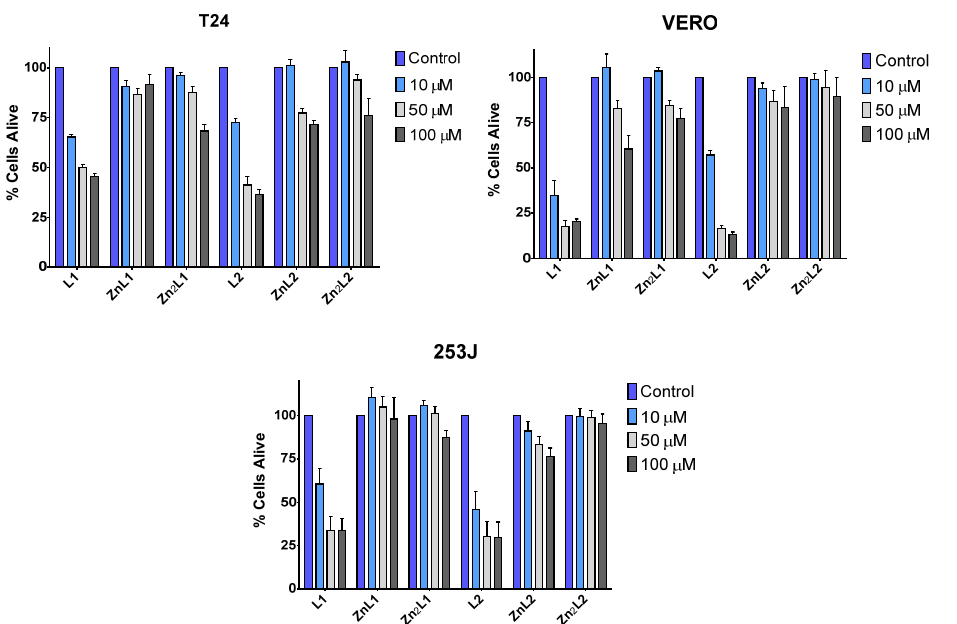
Figure 9. Low toxicity of L1 and L2 metal complexes. Toxicity of L1 , L2 and their metal complexes in mammalian cell lines. T24, VERO, and 253J cell lines were treated with 10, 50, and 100 μ M of the compounds for 48 h to assess their toxicity based on the cell viability of the cell lines. The data are two independent experiments performed in triplicate.